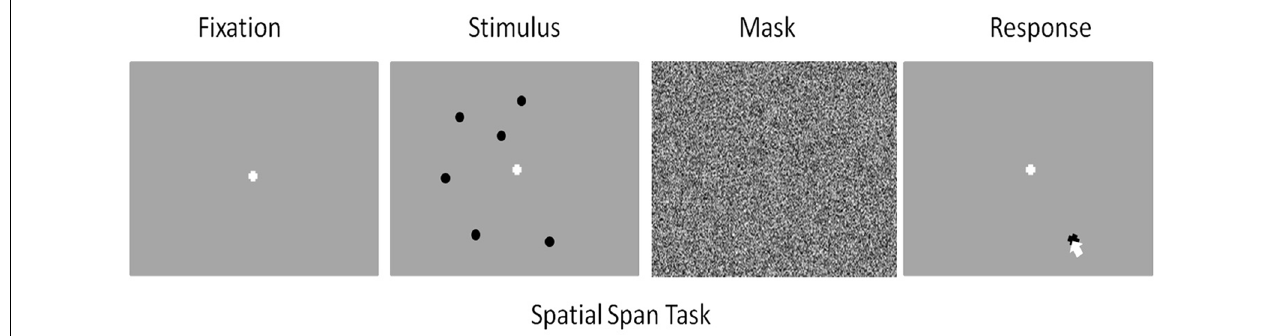
FIGURE 1 | Visual representation of the spatial working memory task. Rest-duration: 8 s, Fixation-duration: 1 s, Stimulus-duration: 1 s, Random Noise Visual Mask-duration: 4 s, Response-duration: variable.